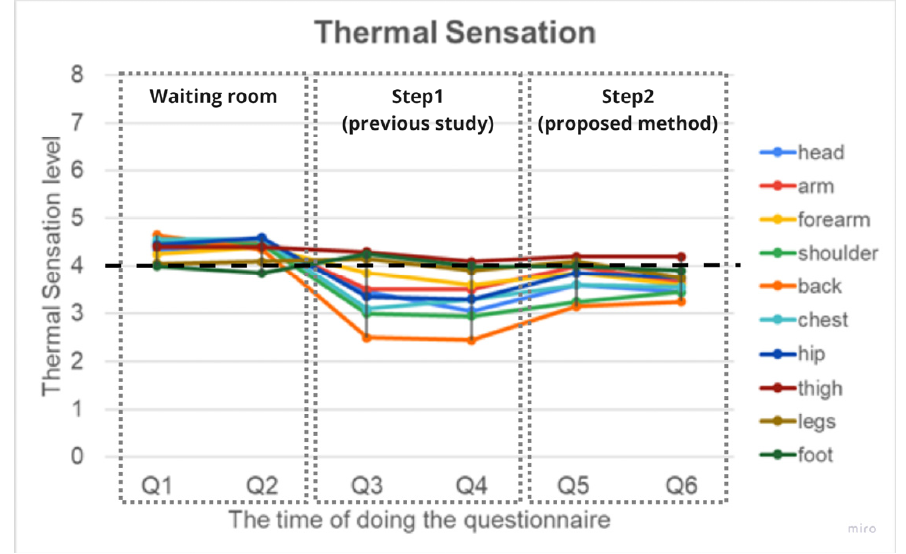
Figure 11. Average thermal sensation for each part of the body.